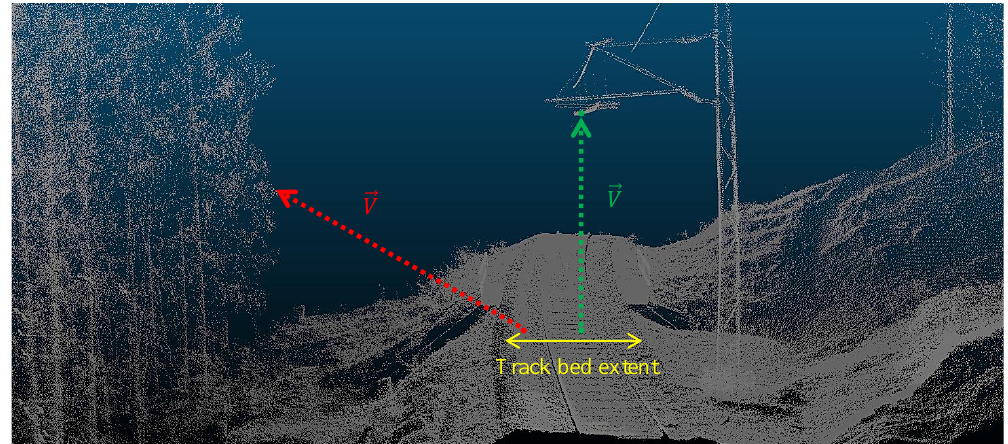
Figure 8. A point above the track bed and within its areal extent is connected to its closest point on the track bed by a vertical green dashed arrow. A point lying outside of the track bed areal extent is connected to its closest point on the track bed by a non-vertical red dashed